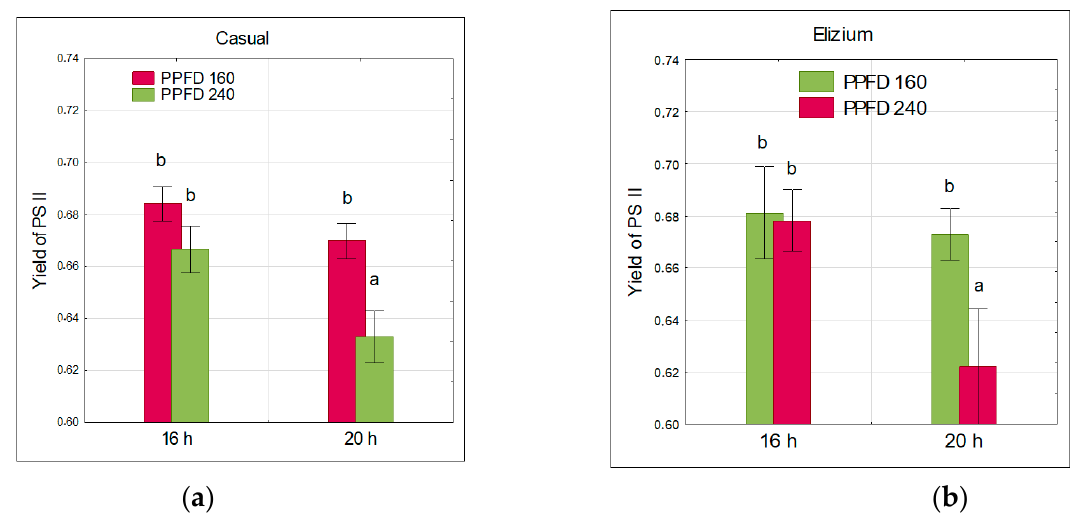
Figure 3. Quantum Photosynthetic Yield of PSII (Y) of cv. ‘Casual’ ( a ) and cv. ‘Elizium’ ( b ) romaine lettuce grown under different light environments (photoperiod 16 and 20 h and PPFD 160 and 240 µmol m − 2 s − 1 ). Bars represent means ± SE. Means followed by the same letter are not significantly different ( p < 0.05) according to Tukey’s HSD test.